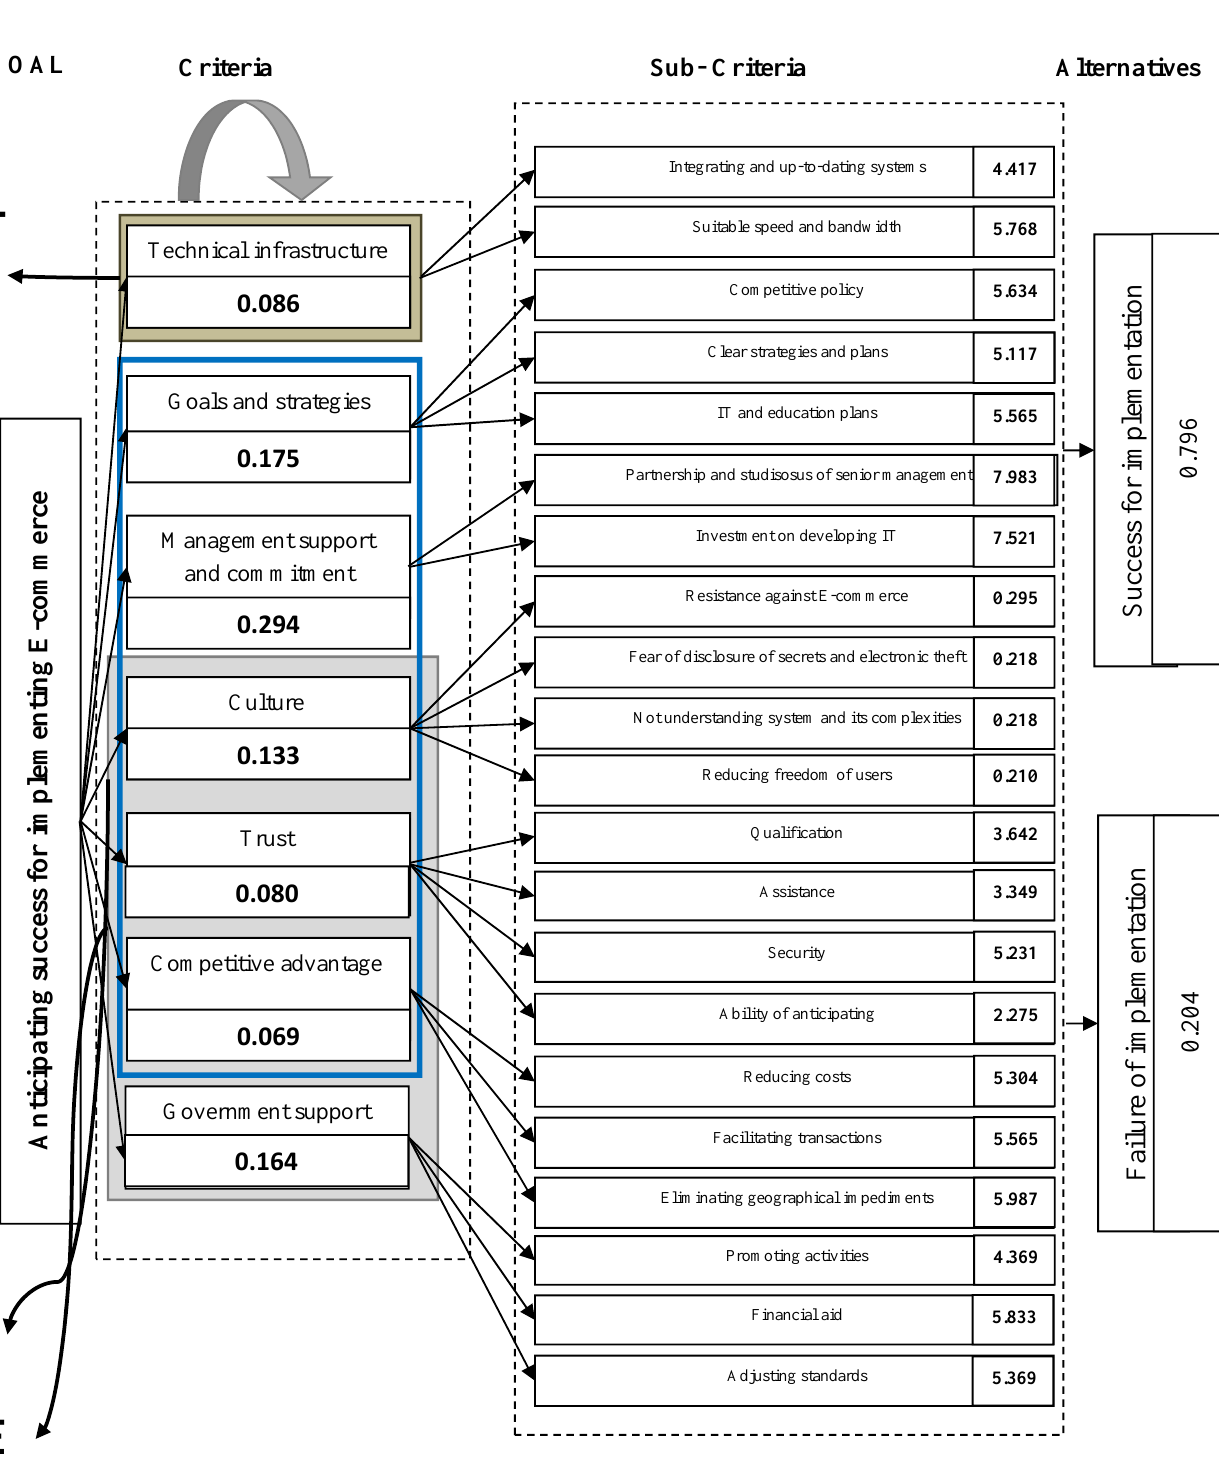
Fig. 2. Network structure and summary of values, factors, sub-factors and